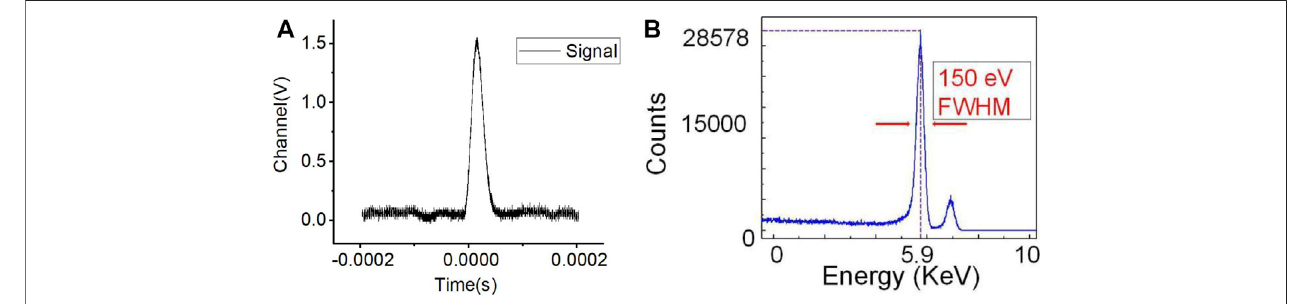
FIGURE 10 | (A) an oscilloscope channel signal; (B) SDD energy spectrum with a high voltage of 300 V (absolute value), and the FWHM is 150 eV.